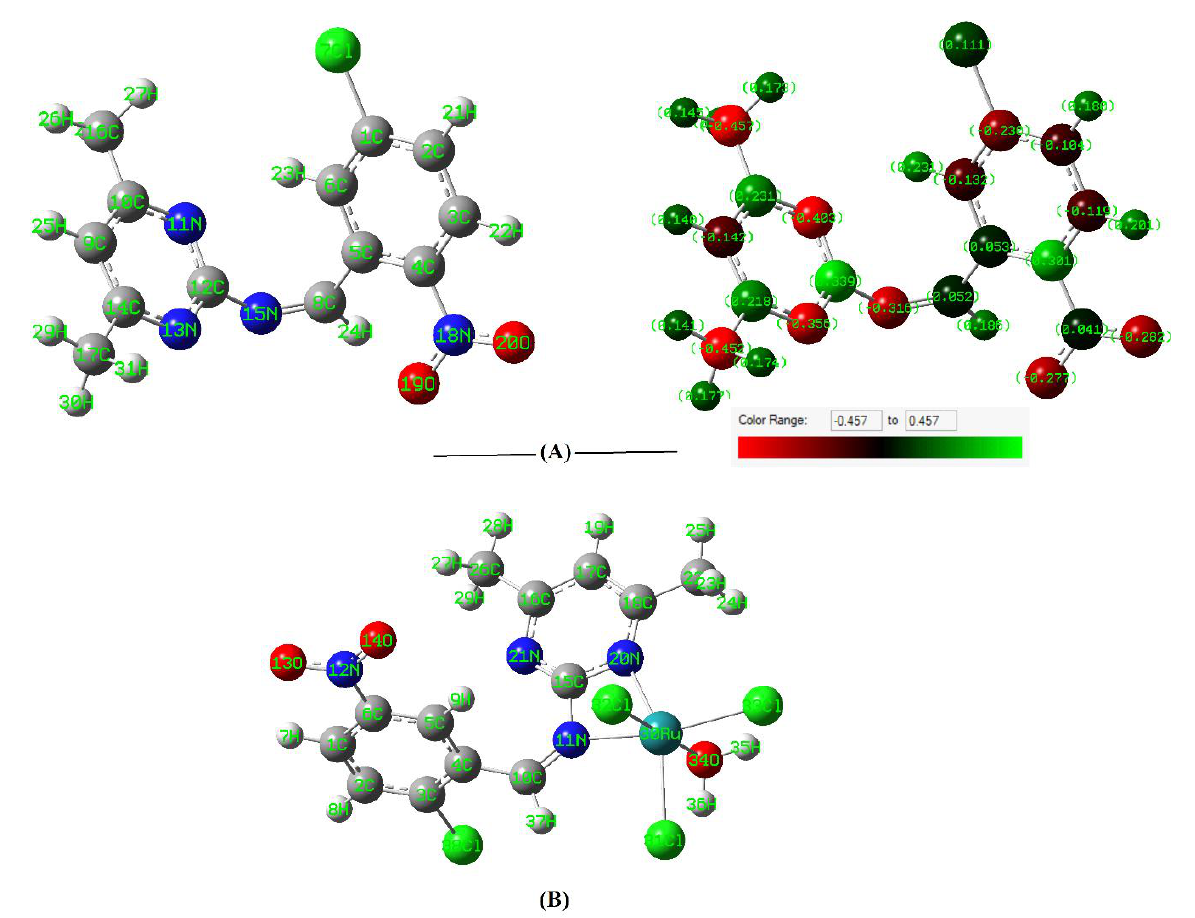
Figure 1. ( A ) The geometrically optimized structure and the charge distribution on atoms of the ligand L (atoms are colored according to their charges). ( B ) The geometrically optimized structure of the ruthenium complex RuL